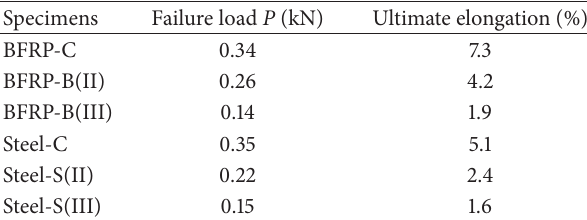
Table 4: Tensile capacity of the bundles and wires.